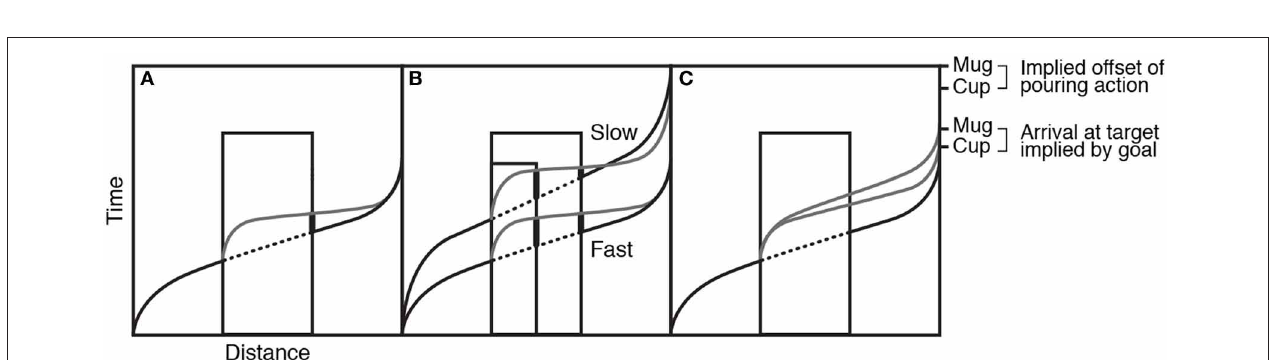
sources of lag error when occluder duration changes. Panel (D) shows the different predictions of the two sources of lag error when motion speed changes. See text for detailed explanations. Figure adapted from Prinz and Rapinett (2008) (p. 226). Copyright by IOS Press. Adapted with permission.